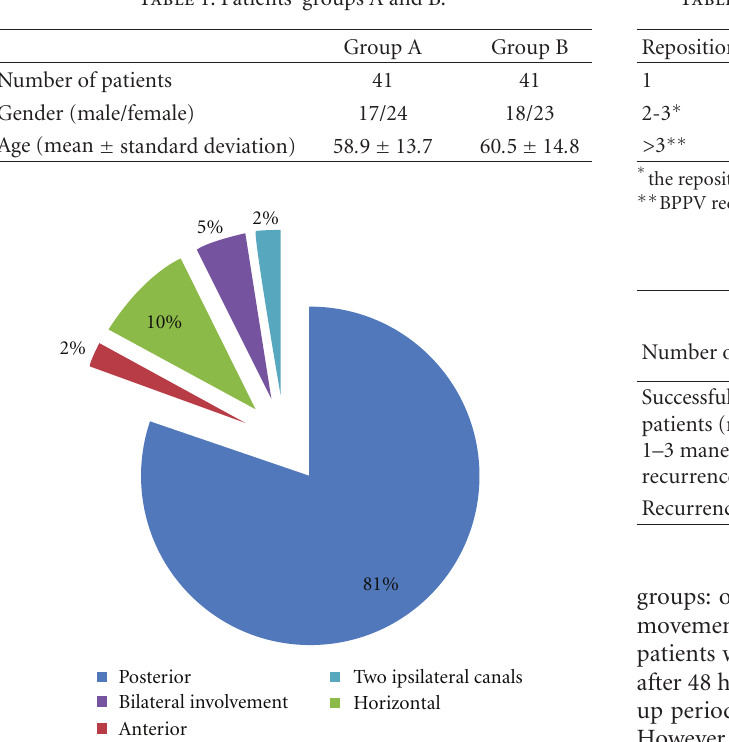
Table 1: Patients’ groups A and B.